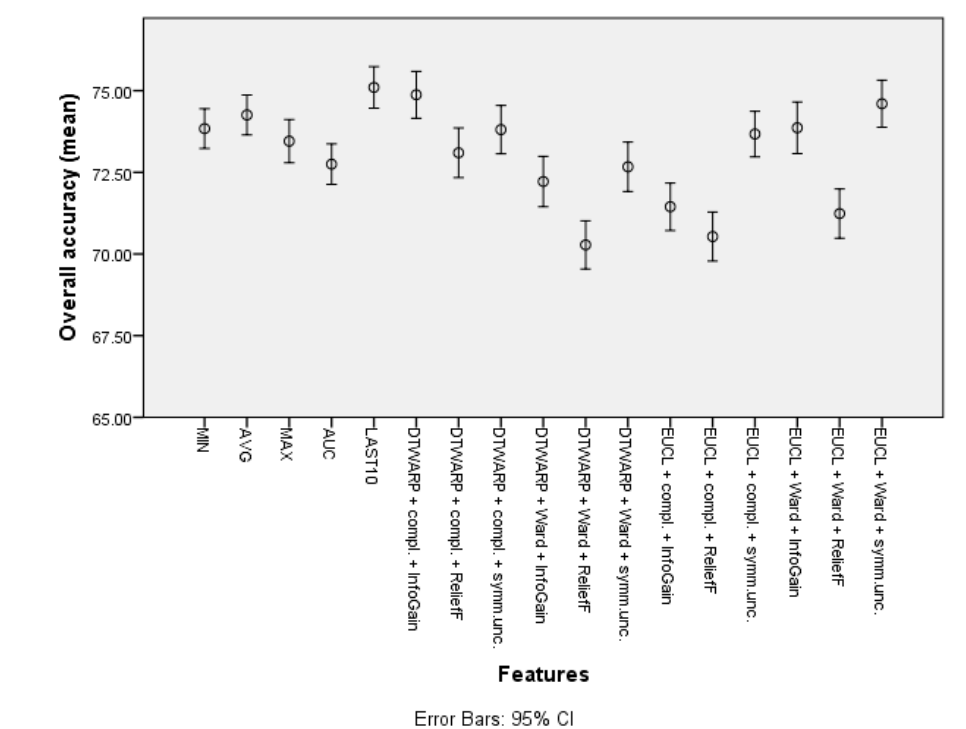
Figure 11. The overall accuracy of SVMs: mean values and 95% confidence intervals.